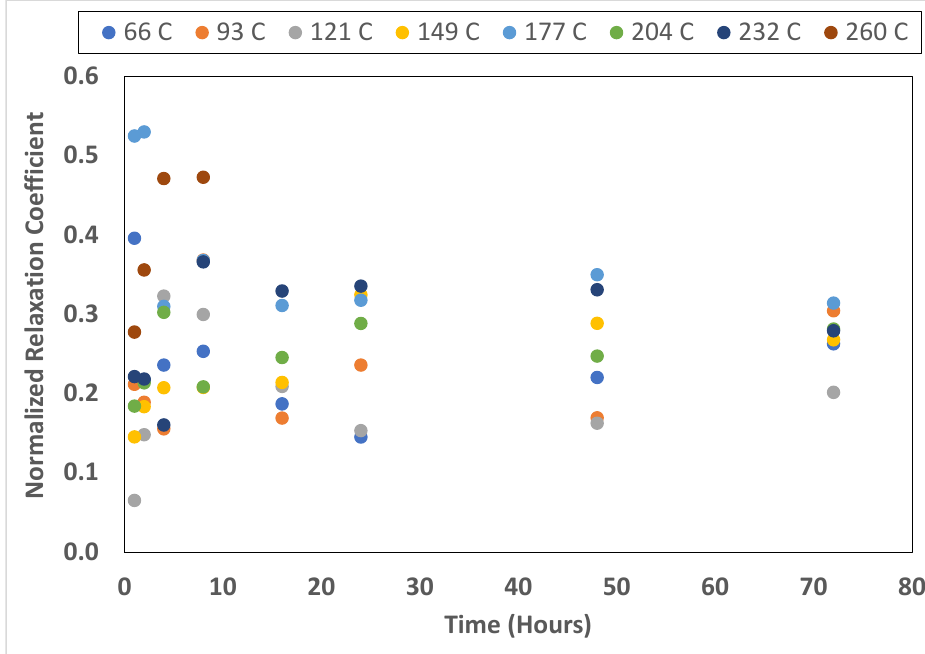
Figure 3. Normalized relaxation coefficient as a function of time and temperature of prior thermal aging.